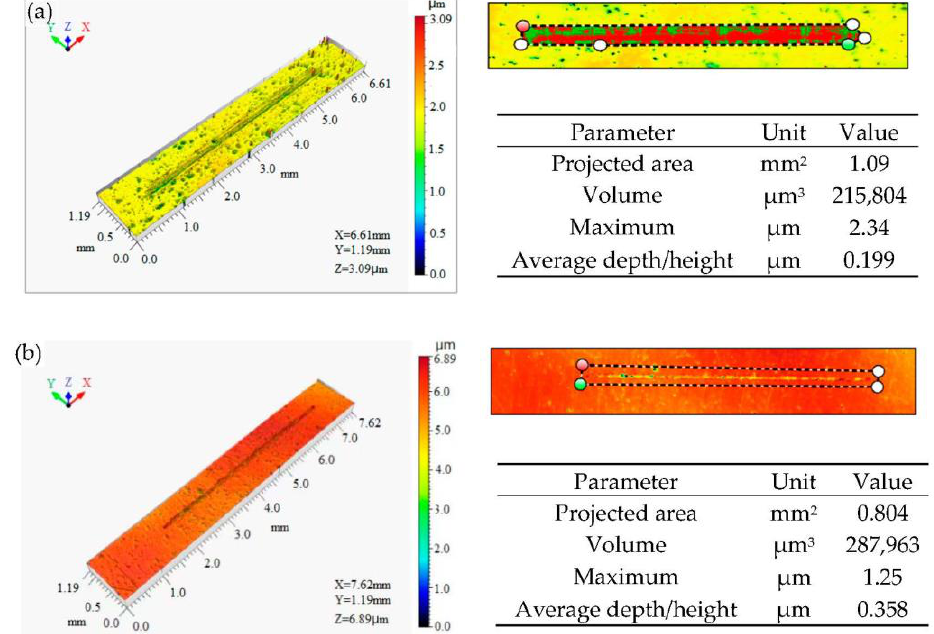
Figure 9. Three-dimensional wear track morphologies and wear volume of Stellite 20 coating: ( a ) HVAF spray coating; ( b ) HVOF spray coating.